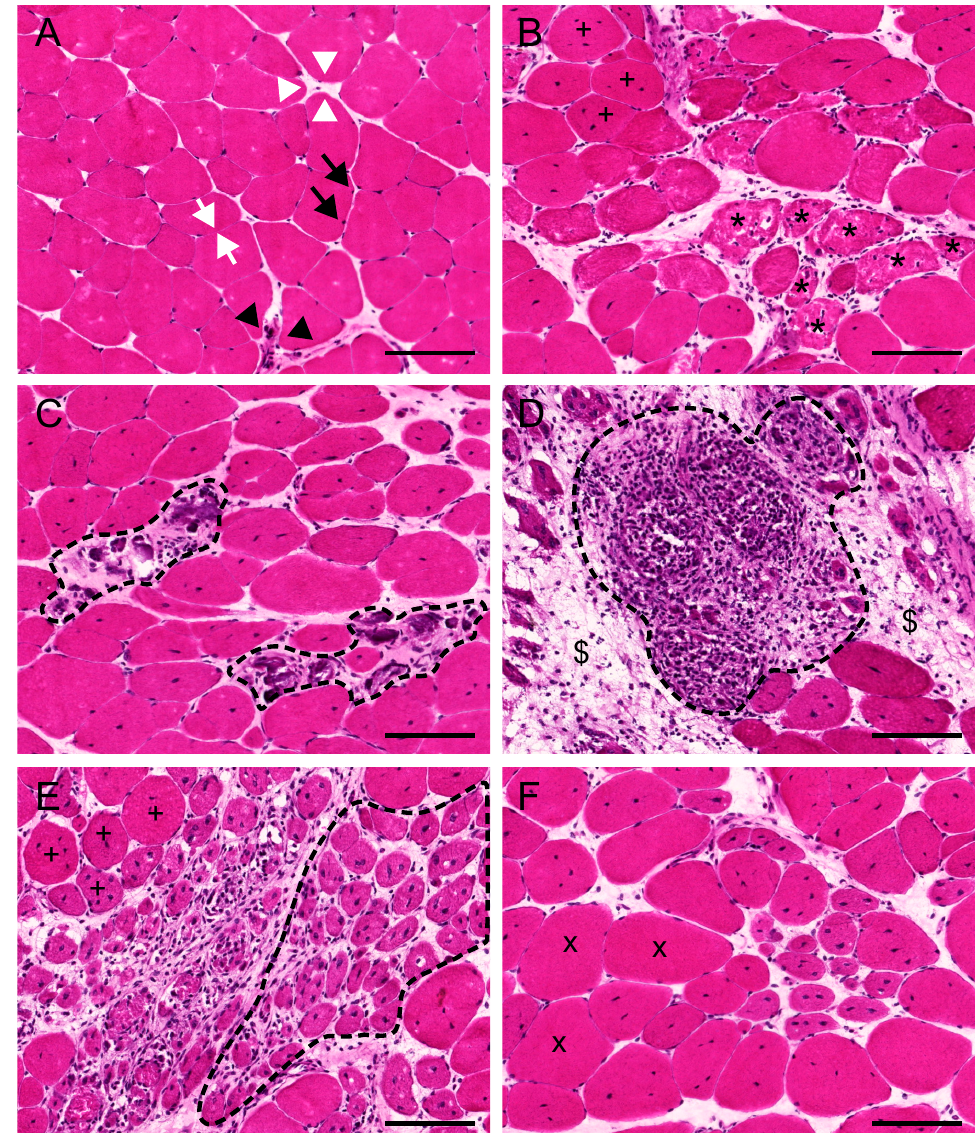
Figure 2. Pathological changes seen in the rectus femoris muscle of mdx mice stained with haemo- toxylin and eosin. ( A ) General appearance of muscle fibres in a 3-month-old wild type (WT) animal. Fibres (pink) show similar sizes and little connective tissue within the perimysium (white arrows) and the endomysium (white arrowheads). Nuclei (dark purple) are located at the periphery of the muscle fibre (black arrows) and capillaries are evident (light pink) within the endomysium (black arrowheads). ( B ) Clusters of necrotic fibres with basophilic inflammatory cells inside (dark purple) and fragmented sarcoplasm (*) surrounded by regular fibres and regenerative fibres (+) in an age-matched mdx mouse. ( C ) Mild and ( D ) severe inflammatory cell infiltration, respectively, phagocytising necrotic fibres (black dashed line), surrounded by fibrotic tissue ($). ( E ) Clusters of small rounded centrally nucleated fibres in similar, early, stage of regeneration or immaturity (black dashed line) adjacent to a group of medium-sized regenerating fibres in later stages of maturation (+). ( F ) In some areas of the muscle, non-centrally nucleated hypertrophic fibres (x), larger than the fibres seen in WT muscles, can be observed. Scales: 100 µ